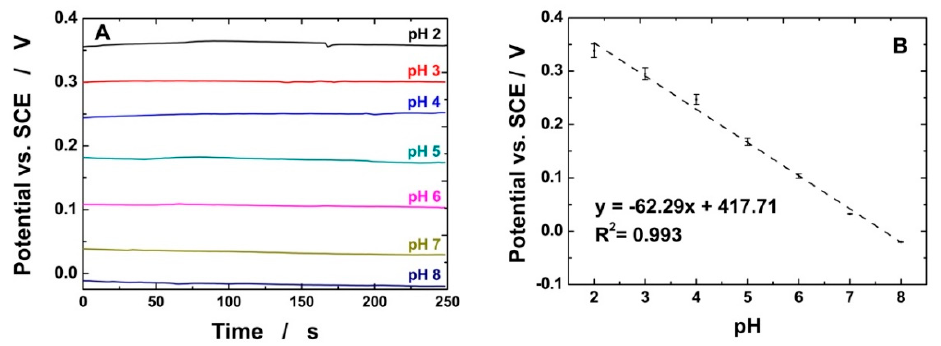
Figure 5. ( A ) OCP vs. time curves; ( B ) calibration line of PANI/rGO/ITO-PET electrode.